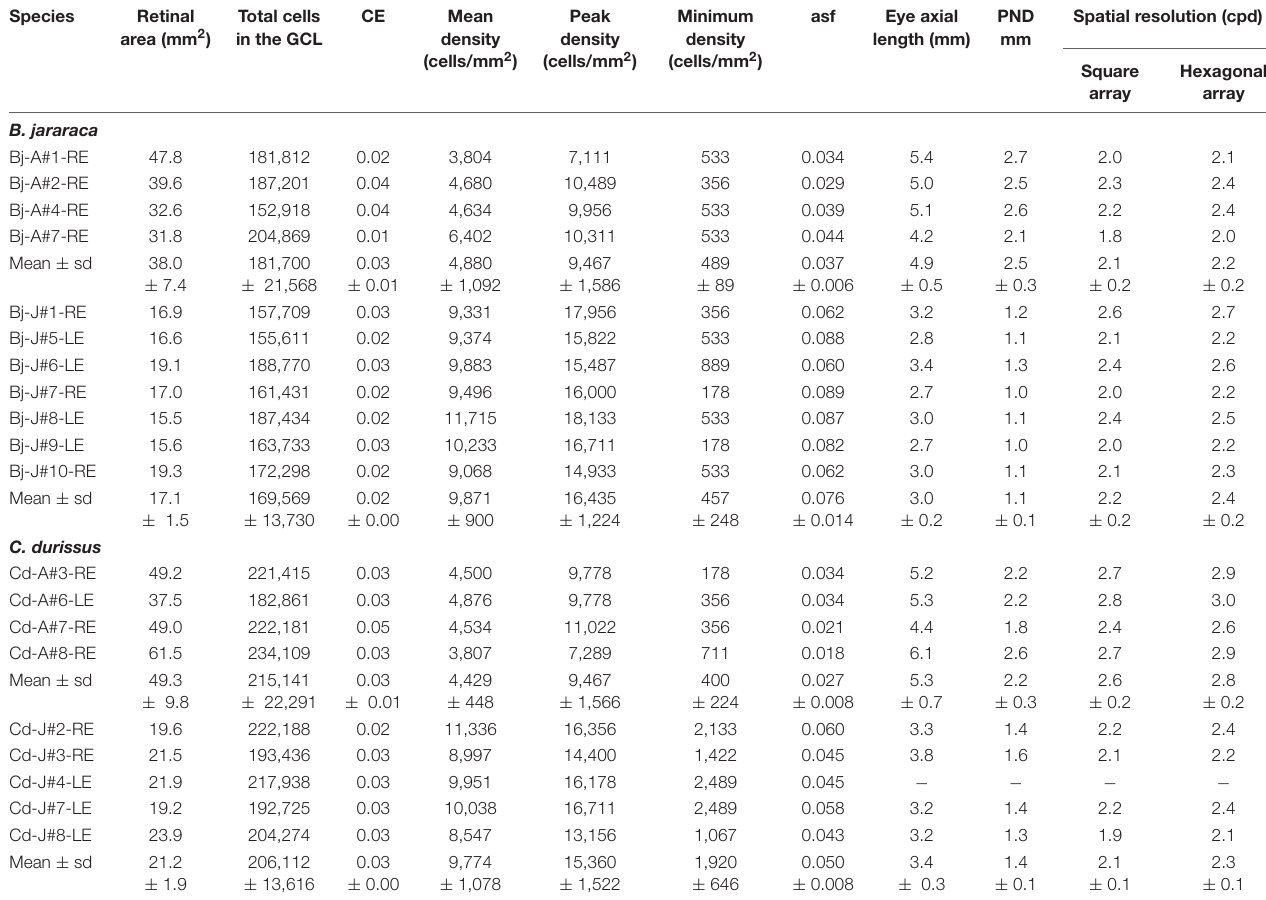
TABLE 4 | Stereological assessment of the population of GCL cells of adults and juveniles of B. jararaca and C. durissus and anatomical parameters used to estimate the upper limit of spatial resolution.